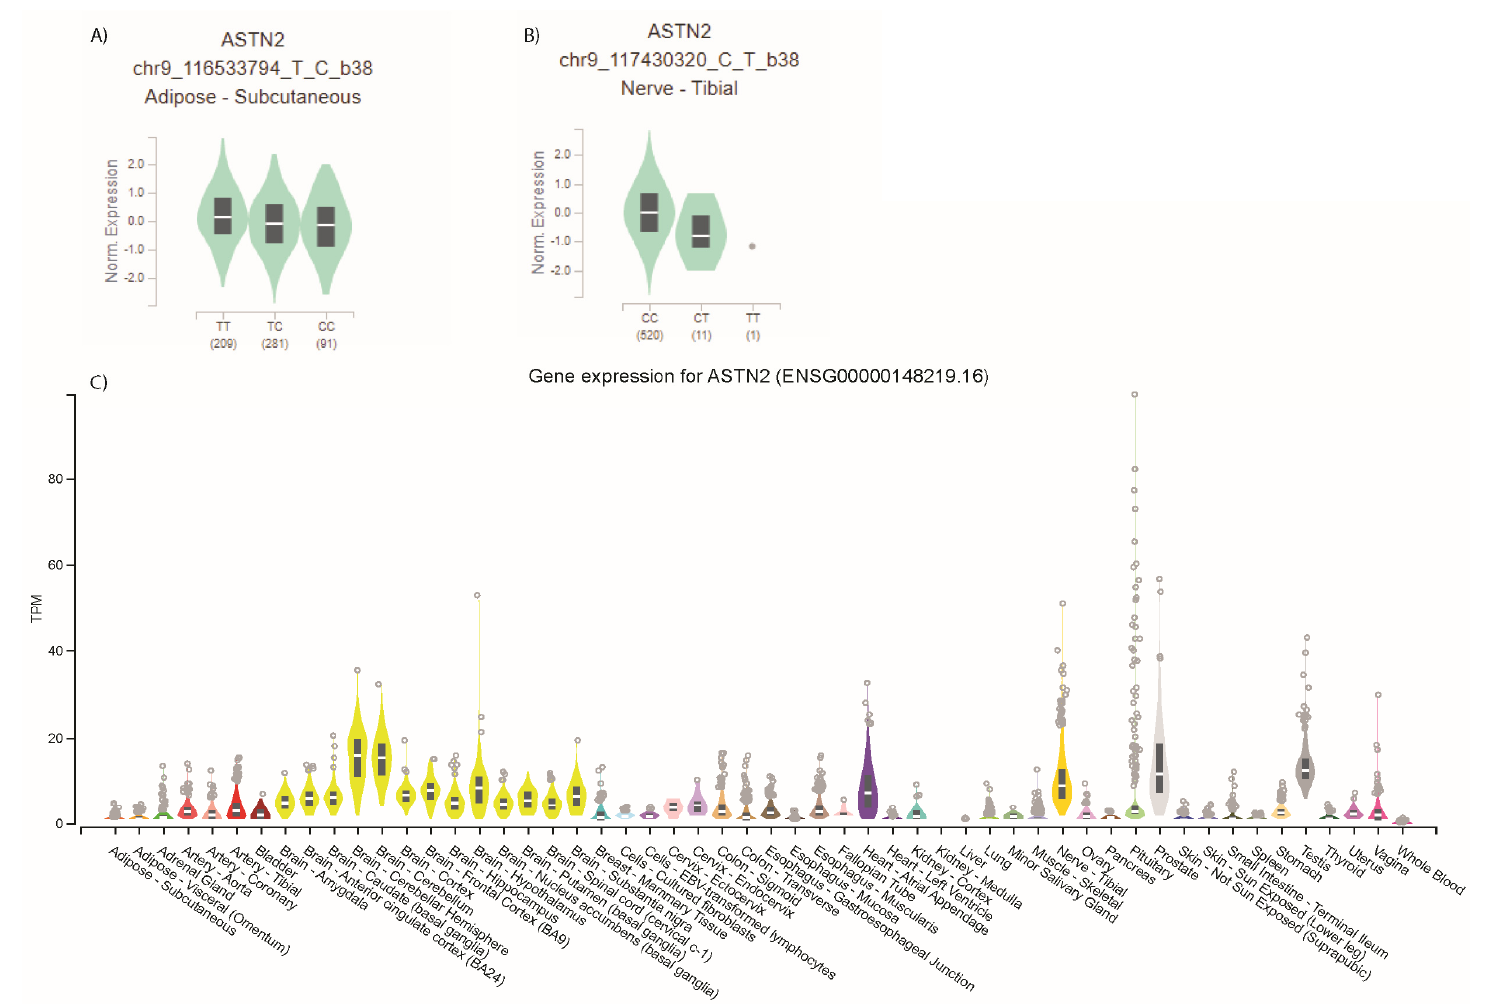
Figure 10. Expression of ASTN2 , ( A ) depends upon genotype of the WHRadjBMI lead, rs6478243, in adipose tissue, and ( B ) depends on the genotype of the anhedonia lead, rs144850429, in tibial nerve tissue, ( C ) in all tissues.